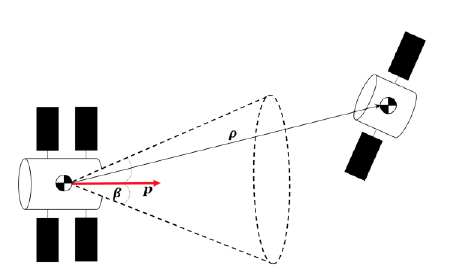
Figure A3. Proximity example